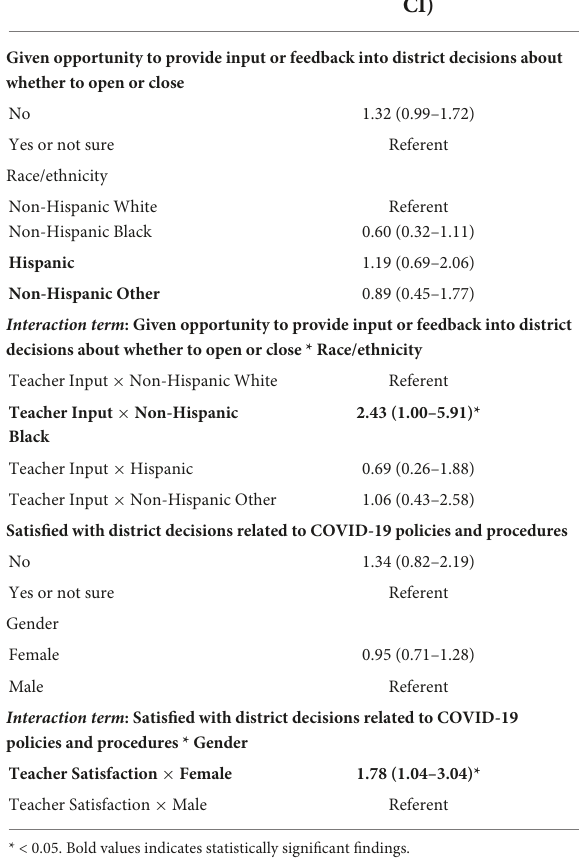
TABLE 3 Interaction terms investigating school policy sentiment by socio-demographic characteristics of K-12 teachers thinking about retiring or leaving the teacher profession more so today than